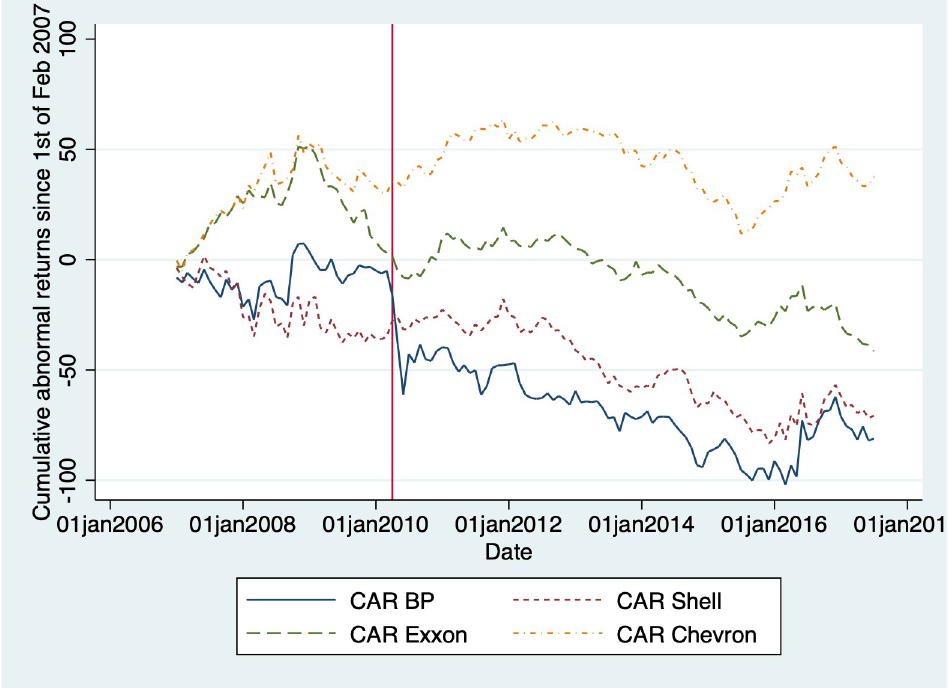
Fig 9. Cumulative Abnormal Returns (CAR) for BP, Shell, Chevron, and